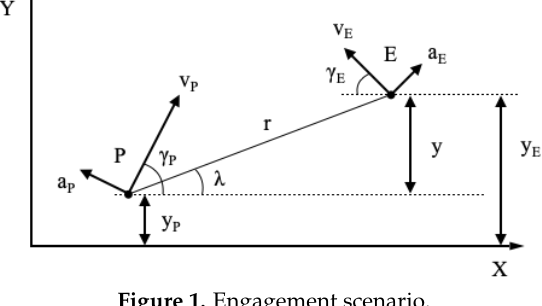
Figure 1. Engagement